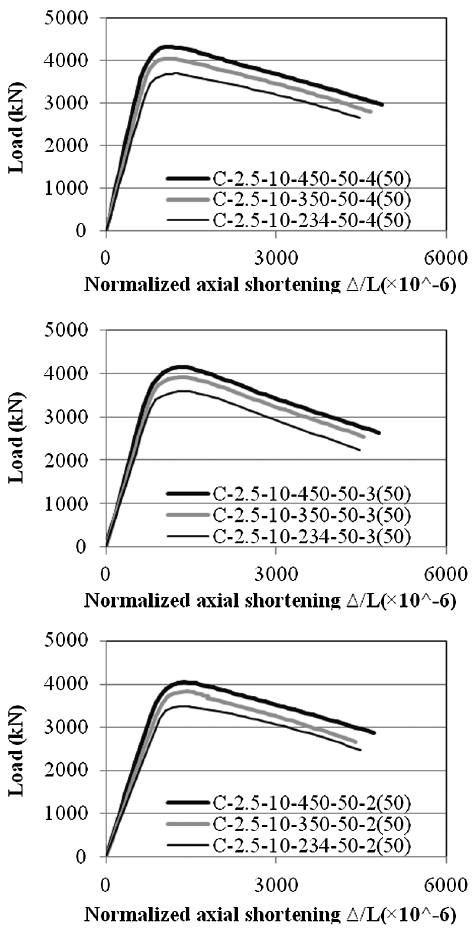
Fig. 15. Effect of concrete compressive strength on ultimate axial load capacity